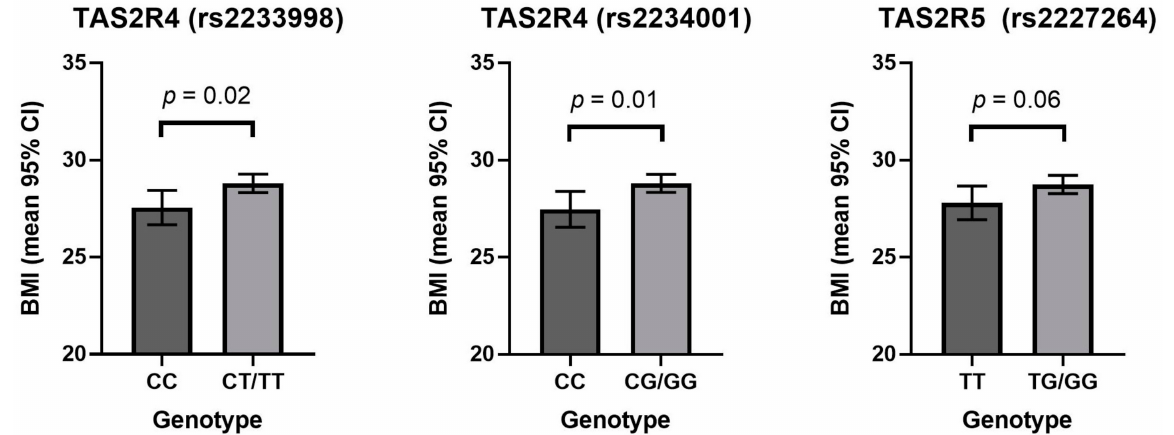
Figure 1. The relationship between TAS2R genotype and BMI. Data are presented as the mean BMI with 95% confidence intervals, adjusted for age and sex.